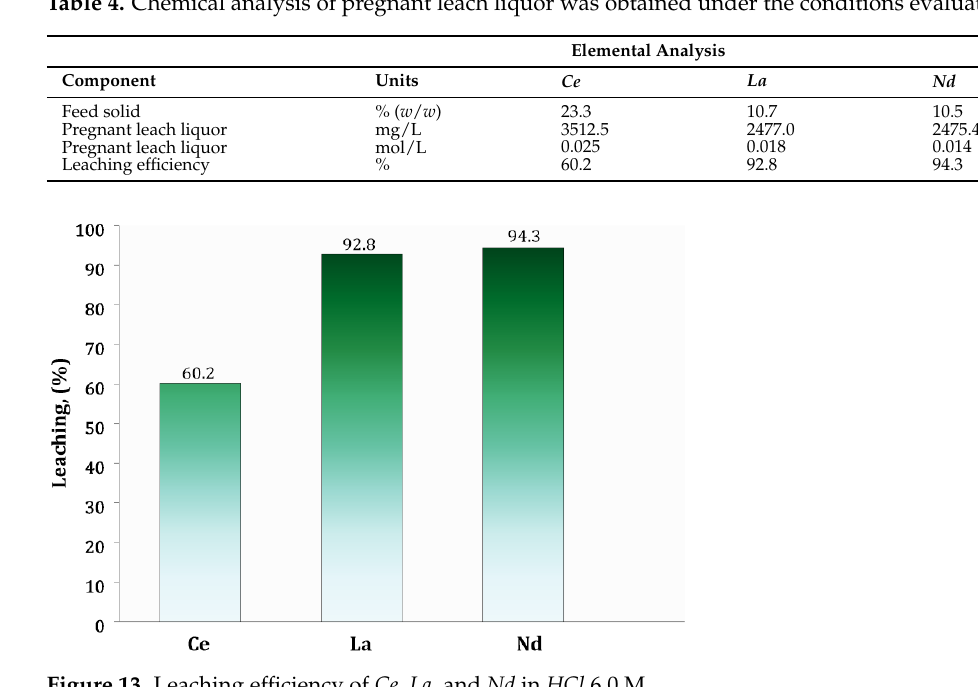
Figure 13. Leaching efficiency of Ce , La , and Nd in HCl 6.0